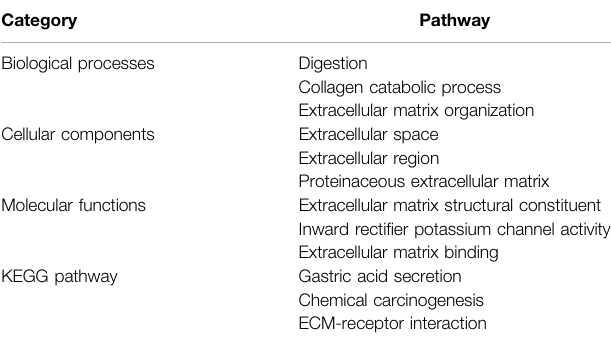
TABLE 4 | Biological functions and pathways that the hub genes are mostly involved